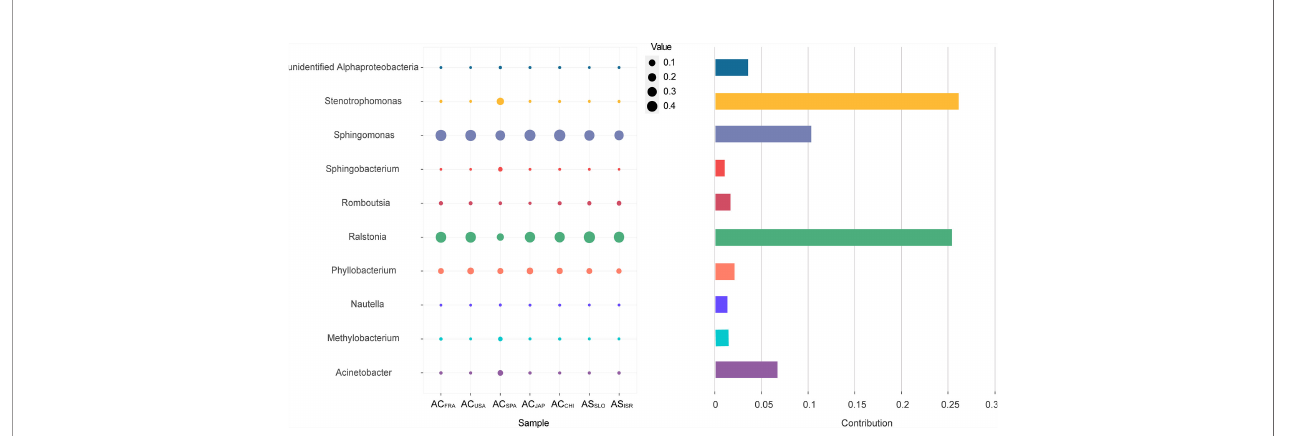
FIGURE 4 | The top 10 genera contributing to the interspeci fi c difference in the microbial community. The vertical axis represents the species. The horizontal axis represents the samples. The bubble size represents the relative sequence abundance of the species. Contribution represents the contribution of the genus in the difference between the A. coerulea and A. solida